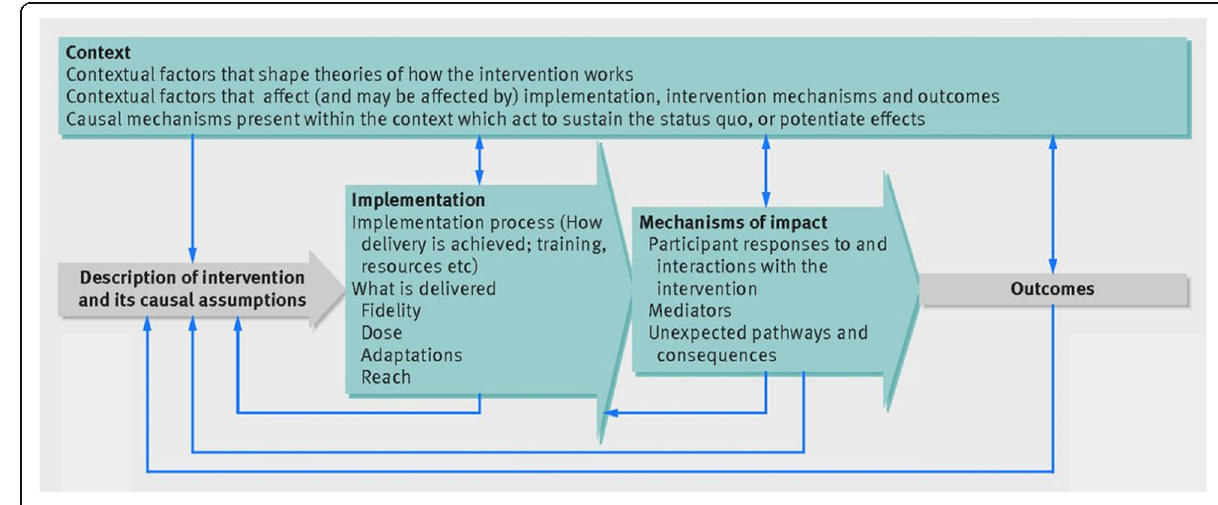
Fig. 1 Process evaluation model by Moore et al.